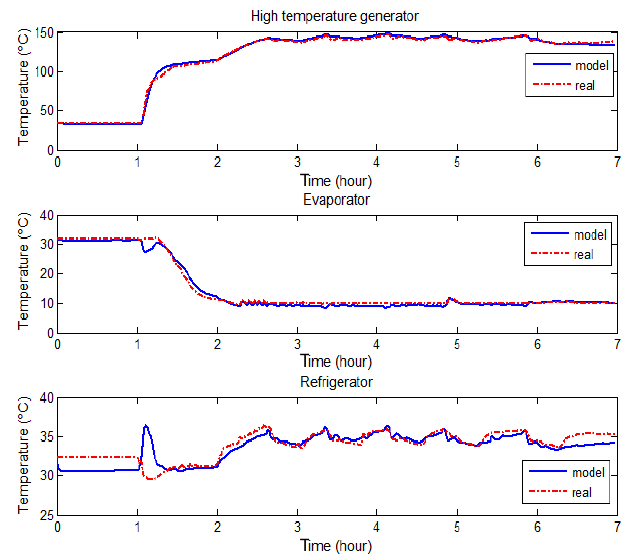
Figure 7. Absorption machine model vs. real: 19 July